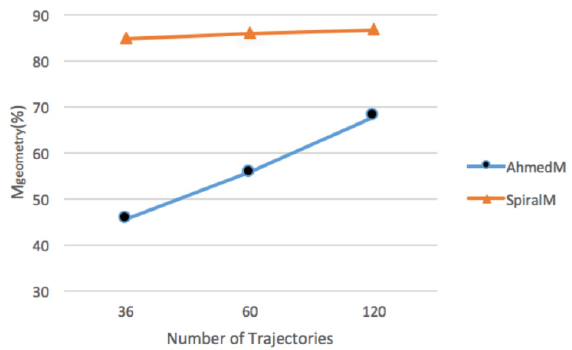
Figure 10. Comparison of results.